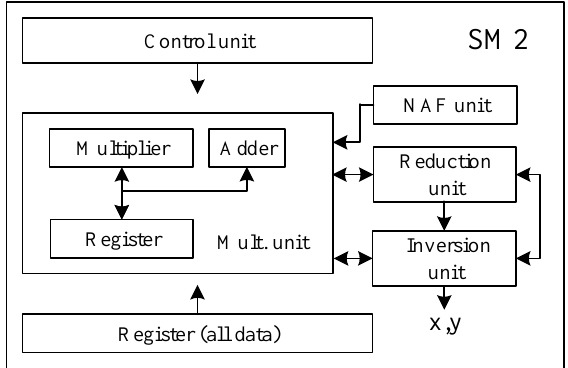
Figure 3. SM2 Architecture diagram.